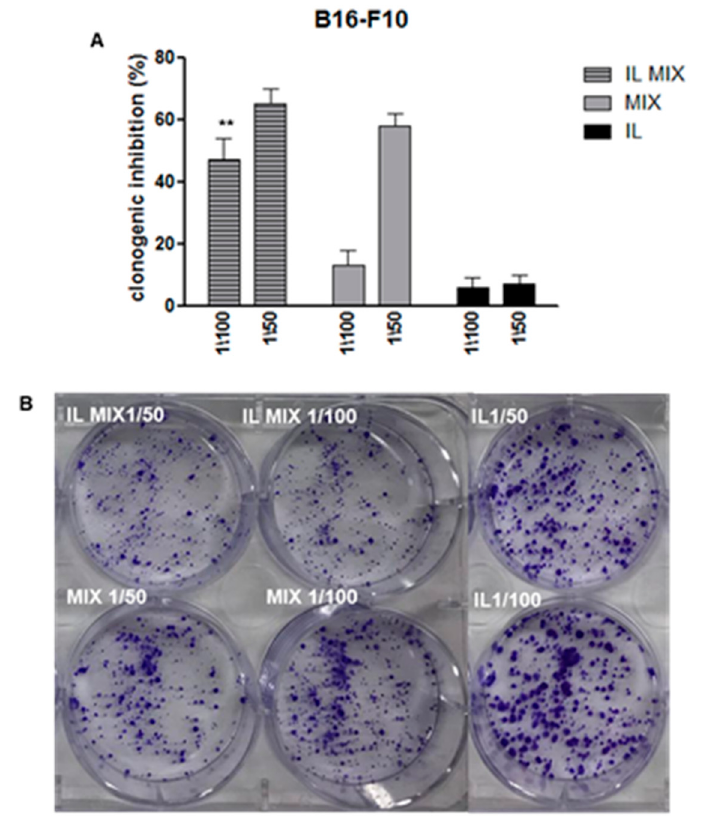
Figure 3. Clonogenic assay in B16-F10 cells. ** IL MIX vs. MIX p < 0.01; ( A ) quantification; ( B ) wells stained with crystal violet. IL: Intralipid ® ; MIX: combination of drugs; IL MIX: MIX co-loaded in IL